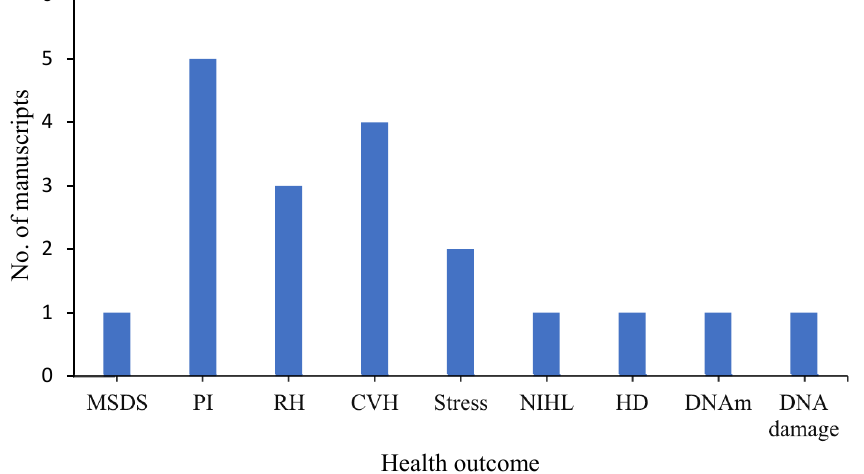
Figure 2. Summary of manuscripts that reported on various health outcomes. Abbreviations: MSDS—musculoskeletal disease symptoms; PI—physical injuries (cuts, lacerations, etc.); RH—respiratory health; CVH—cardiovascular health; NIHL—noise-induced hearing loss; HD—hepatic disease; DNAm—DNA methylation. NB: Some manuscripts reported more than one health outcome.